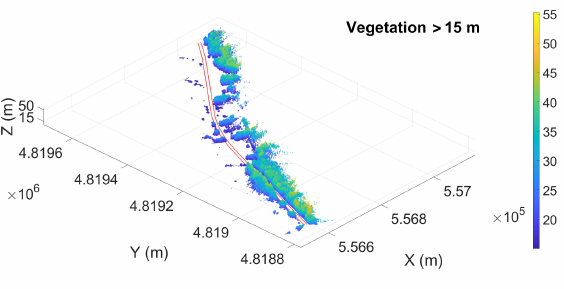
Figure 10. Vegetation points with greater height than 15 m.